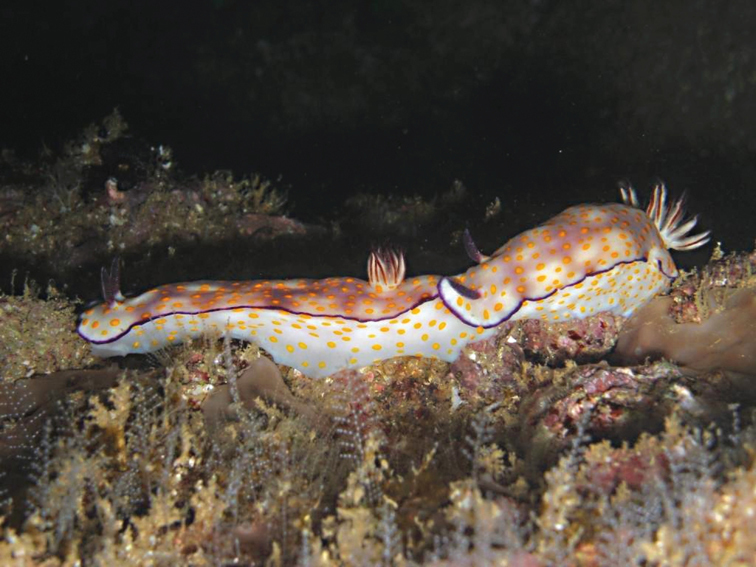
Risbecia pulchella, Oman, photo: S Kahlbrock (no spcm).